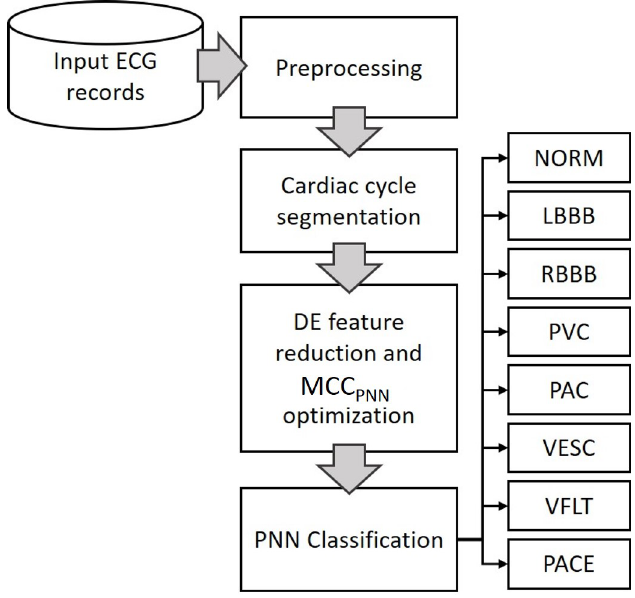
Figure 2. Methodology